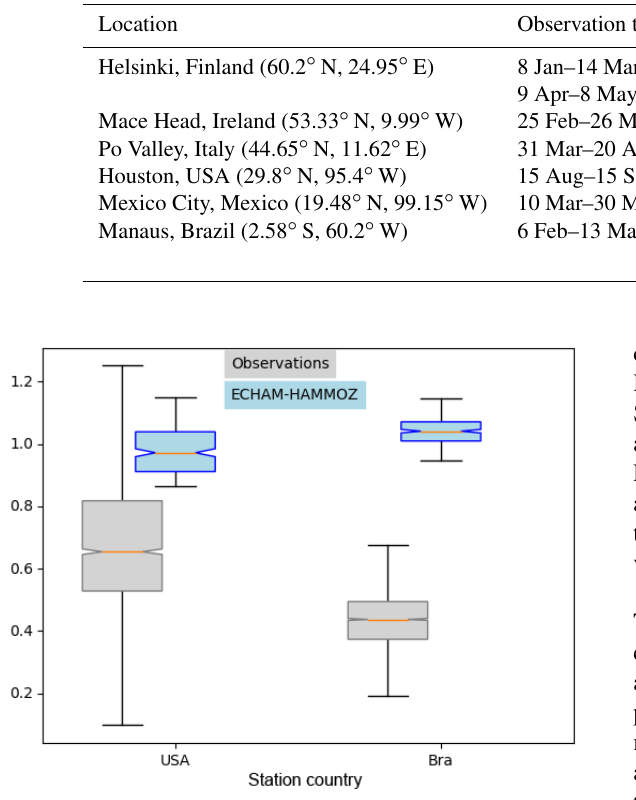
Figure 9. Similar to Fig. 8 showing the corresponding O:C ratios of the subset Houston, Texas, USA, and Manaus, Brazil. The O:C ra- tios shown here are corrected by the factor 1.27 according to Cana- garatna et al.